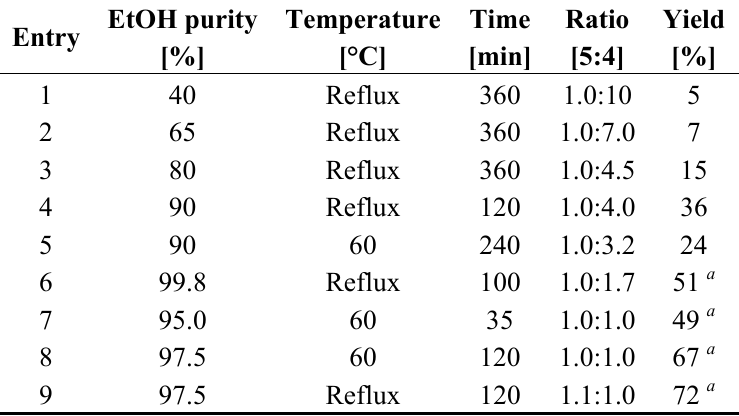
Table 1. Optimization of the conditions of allylic oxidation of 4